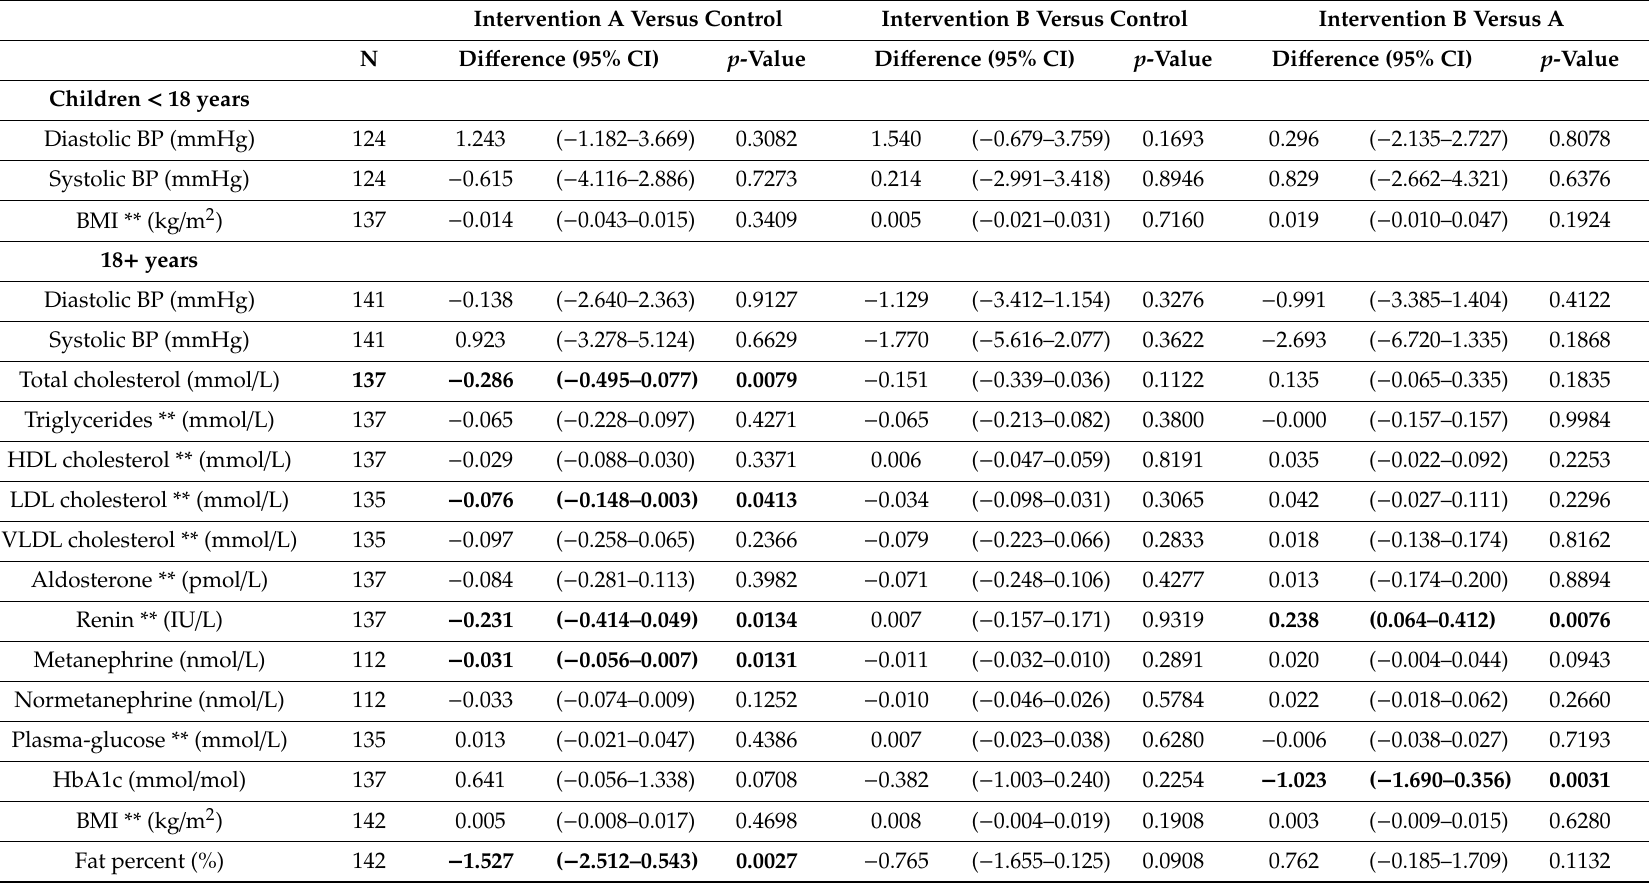
Table 4. Di ff erence between-groups and 95% confidence interval for cardiovascular risk factors (complete